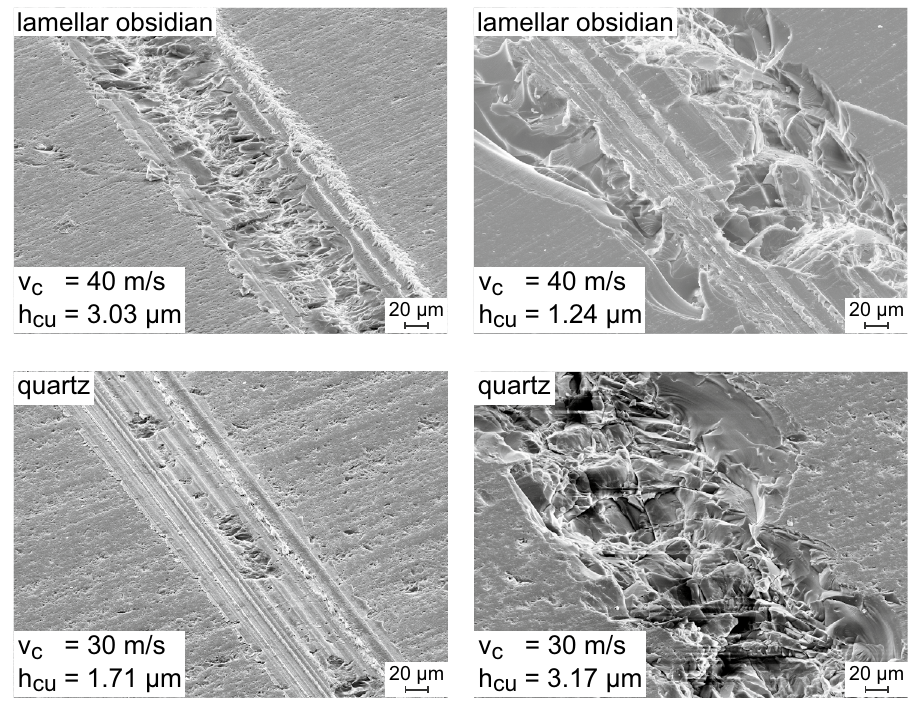
Fig. 10 SEM-images of scratches in obsidian and